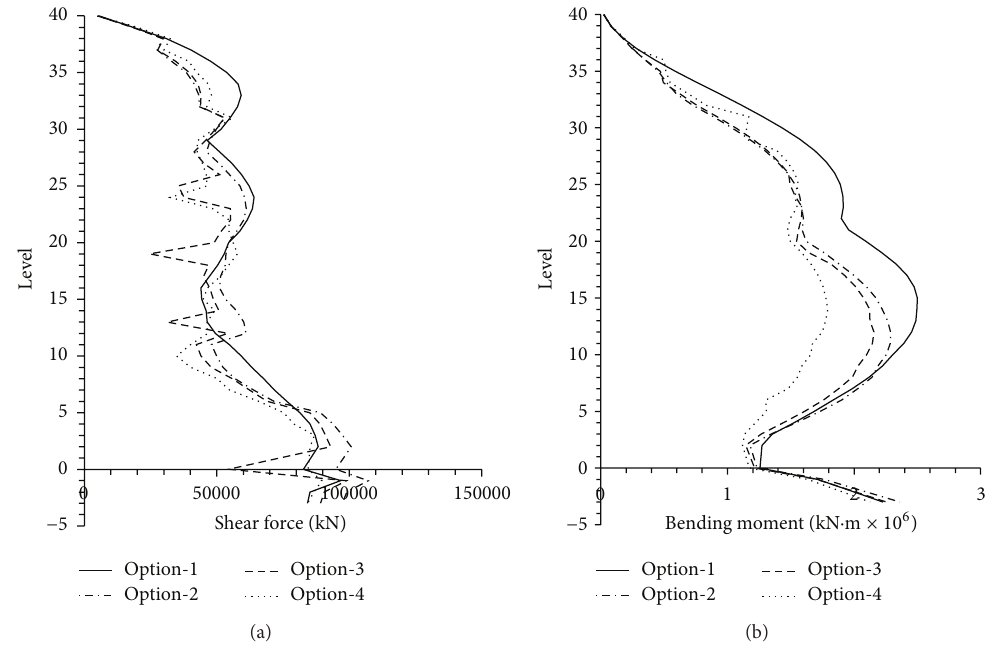
Figure 12: MCE inelastic shear and moment demands in different options. (a) Shear; (b) moment.